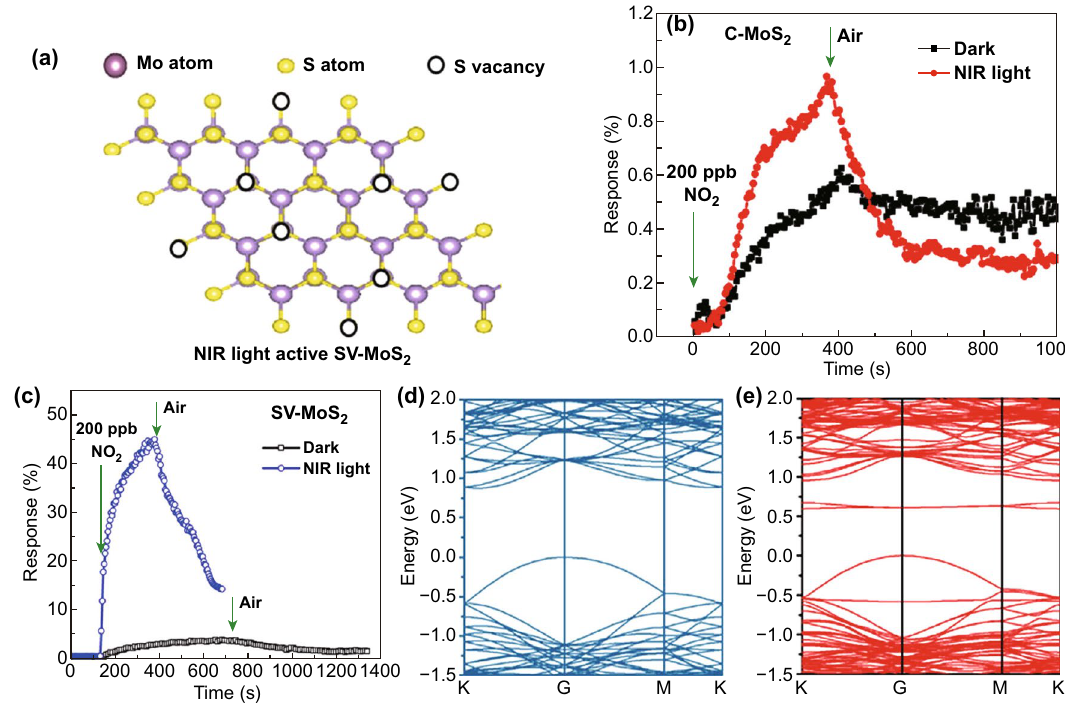
Fig. 18 a Schematic of NIR light-activated sulfur vacancy-enriched MoS 2 (Sv-MoS 2 ). b Response of C-MoS 2 in dark and NIR with NO 2 expo- sure. c Response of Sv-MoS 2 in dark and NIR with NO 2 exposure. Band structure of d C-MoS 2 (blue) and e Sv-MoS 2 (red). Reproduced with permission from Ref. [123]. Copyright (2019) American Chemical Society. (Color figure